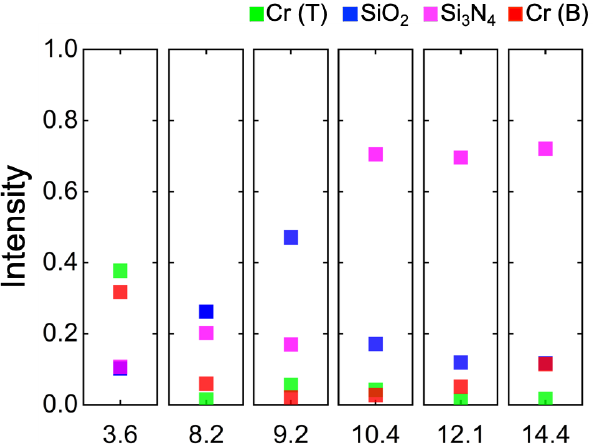
Figure 5. Intensity distribution of the metasurface S3 for each layer at 3.6 µ m, 8.2 µ m, 9.2 µ m, 10.4 µ m, 12.1 µ m, and 14.4 µ